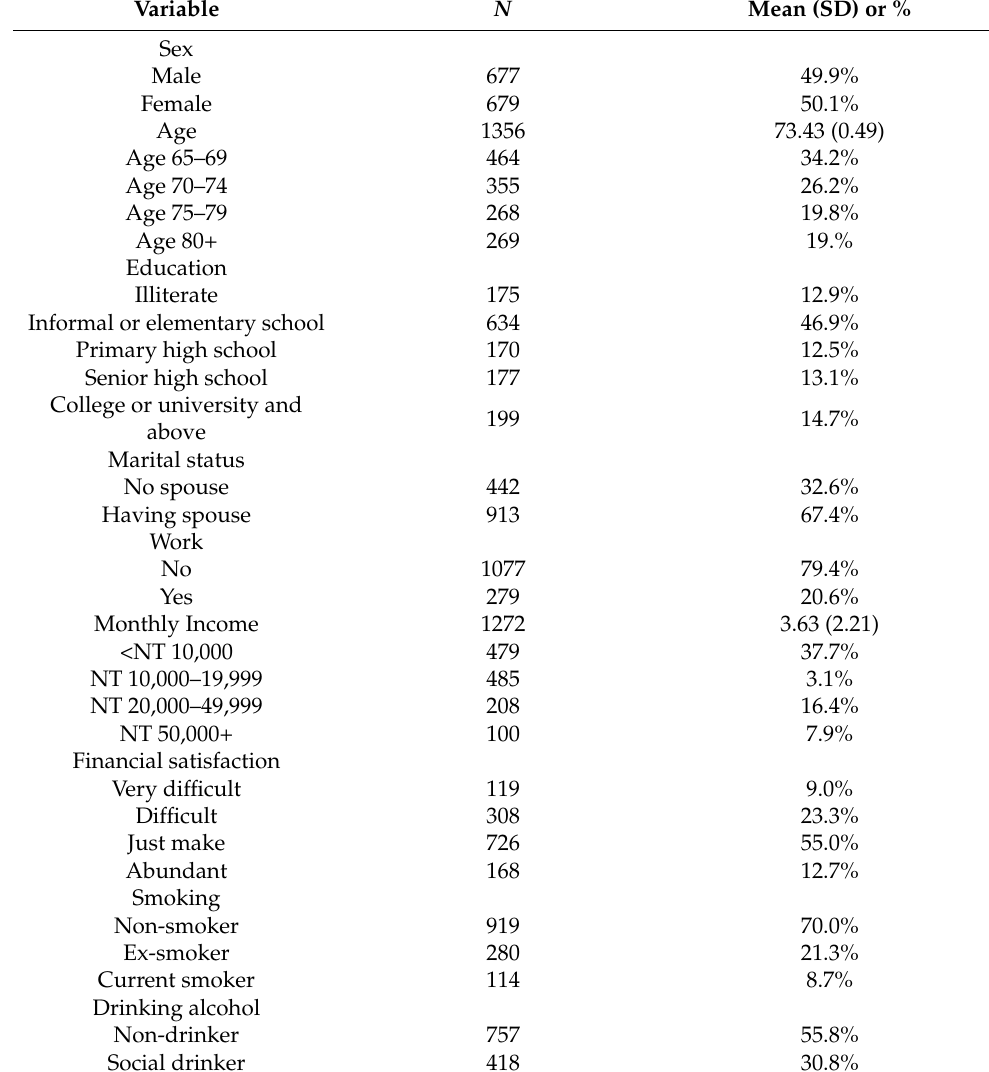
Table 1. Descriptive analysis of the